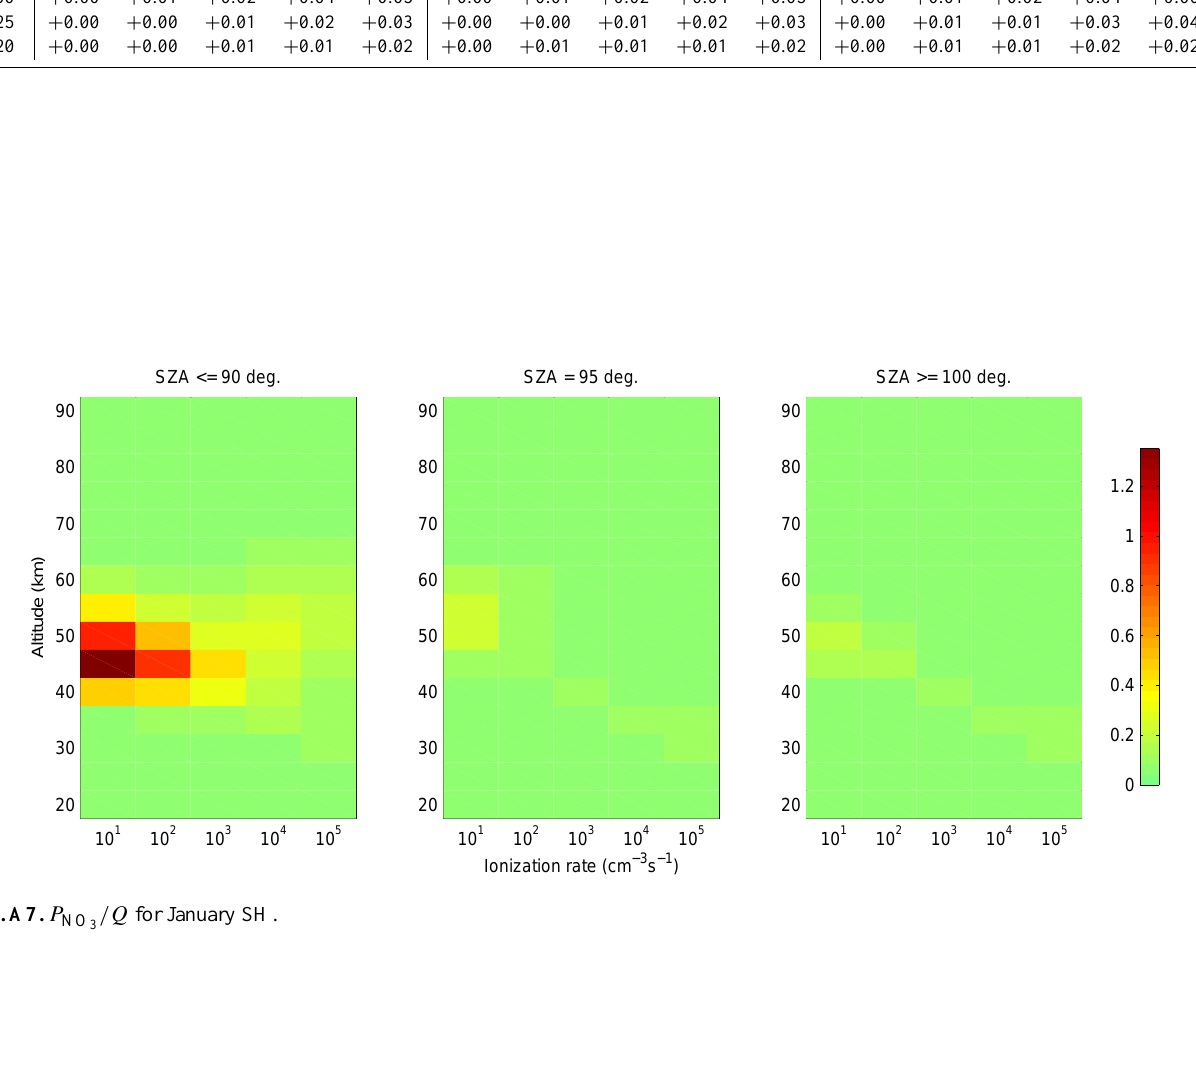
/Q for January 3